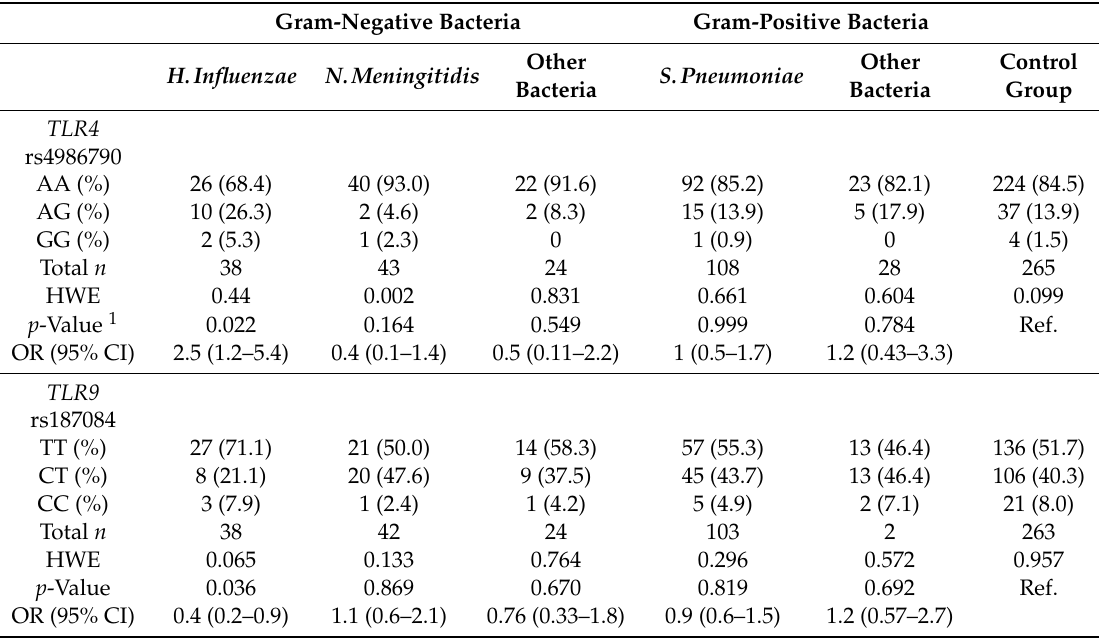
Table 3. Genotype frequencies of the analyzed SNPs TLR4 rs4986790 (AA compared to AG and GG) and TLR9 rs187084 (TT compared to CT and CC) with the causative bacteria of bacterial meningitis